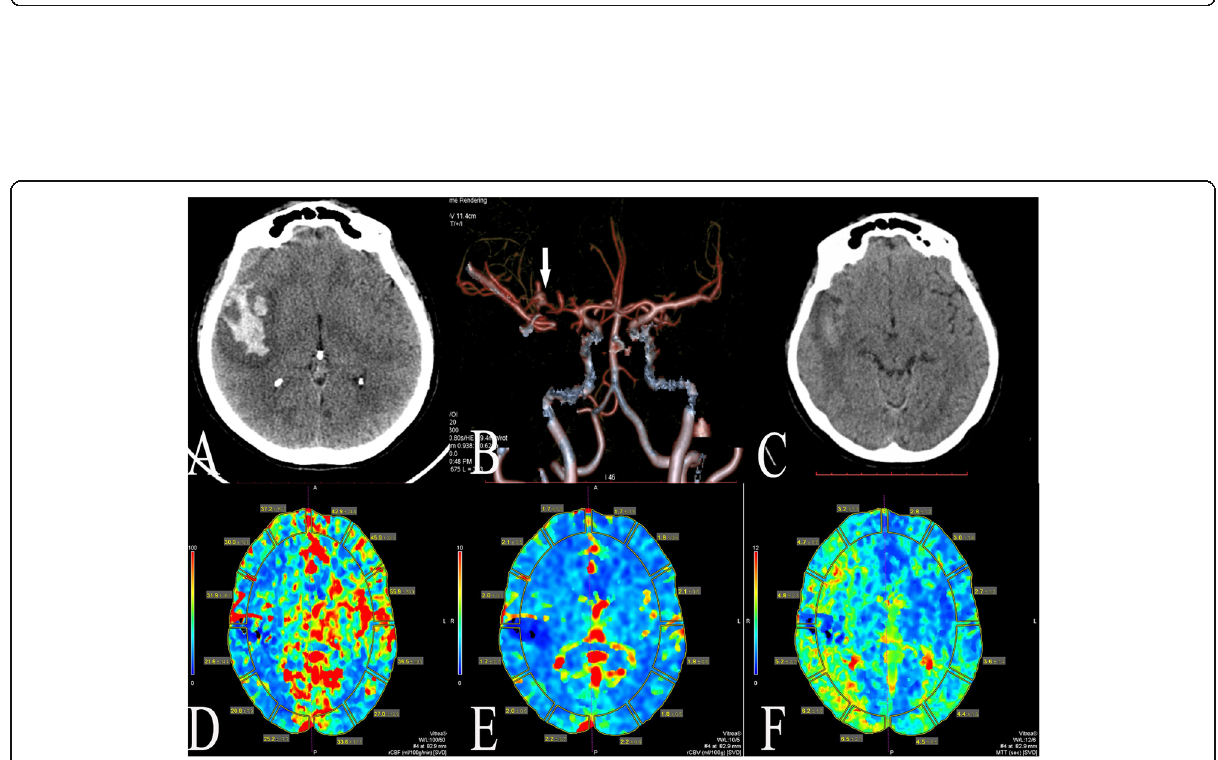
Fig. 5 A 45-year-old female patient presented with severe headache and neck stiffness of 1-day duration with no motor deficit. On admission non-contrast CT ( a ) shows right temporal hematoma with surrounding edema and right Sylvian fissure SAH. Volume rendering image ( b ) of CTA done 1 day after SAH shows a right MCA saccular aneurysm (arrow) having multiple off branches. Moderate vasospasm of the right MCA M1 and M2 segments. Multiple collaterals are evident. Follow-up CT on discharge after 15 days ( c ) shows reduction of size and density of the hematoma, i.e., clot retraction, with no infarcts. CT perfusion maps ( d – f ) done 1 day after SAH revealed mild perfusion deficit on the right side; reduced CBF ( d ), maintained CBV ( e ), and prolonged MTT ( e ). The maintained CBV despite vasospasm is due to collaterals and